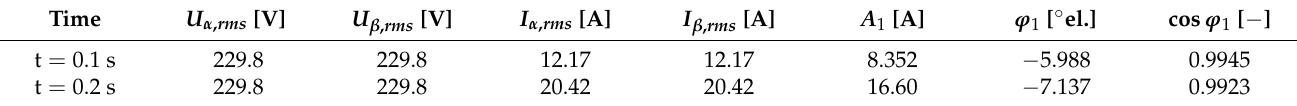
Table 20. Simulation results before and after the change (at steady states).